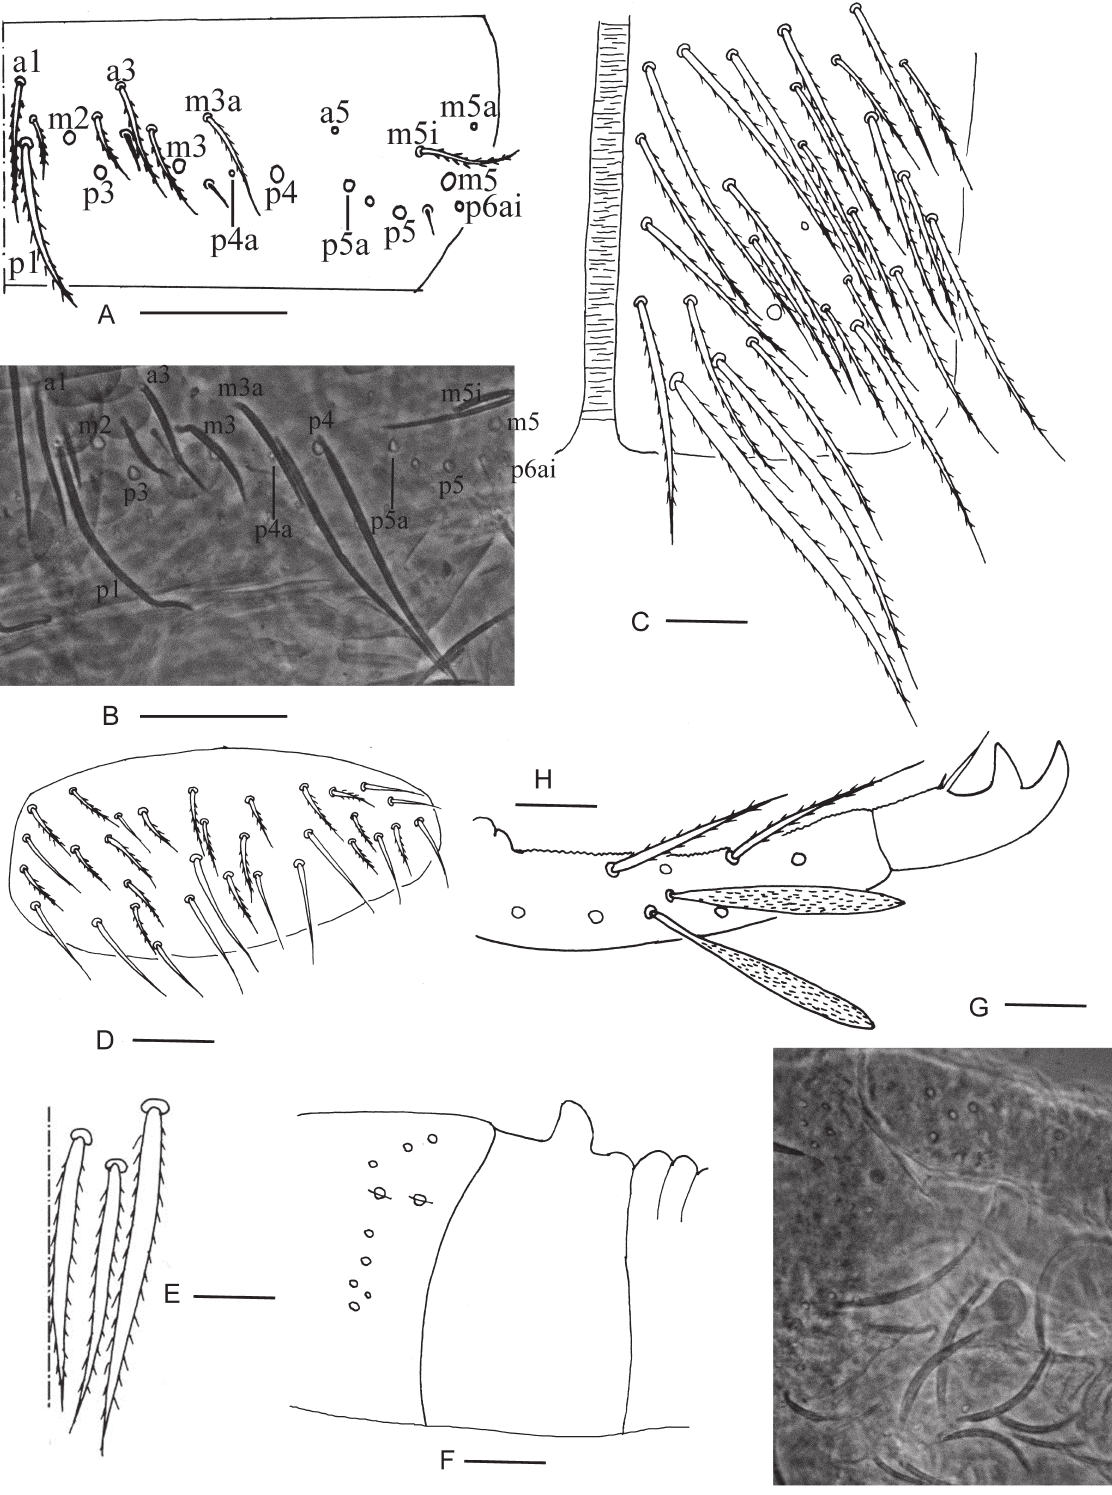
Fig. 16. Lepidocyrtus (S.) wanningensis sp. nov. A−B . Chaetotaxy of Abd. V (right side). C . Anterior face of ventral tube (right side). D . Lateral flap of ventral tube. E . Distal part of ventral manubrium (right side). F−G . Manubrial plaque and proximal part of dens (lateral and dorsal views, respectively). H . Distal part of dens and mucro (lateral view). Scale bars: 20